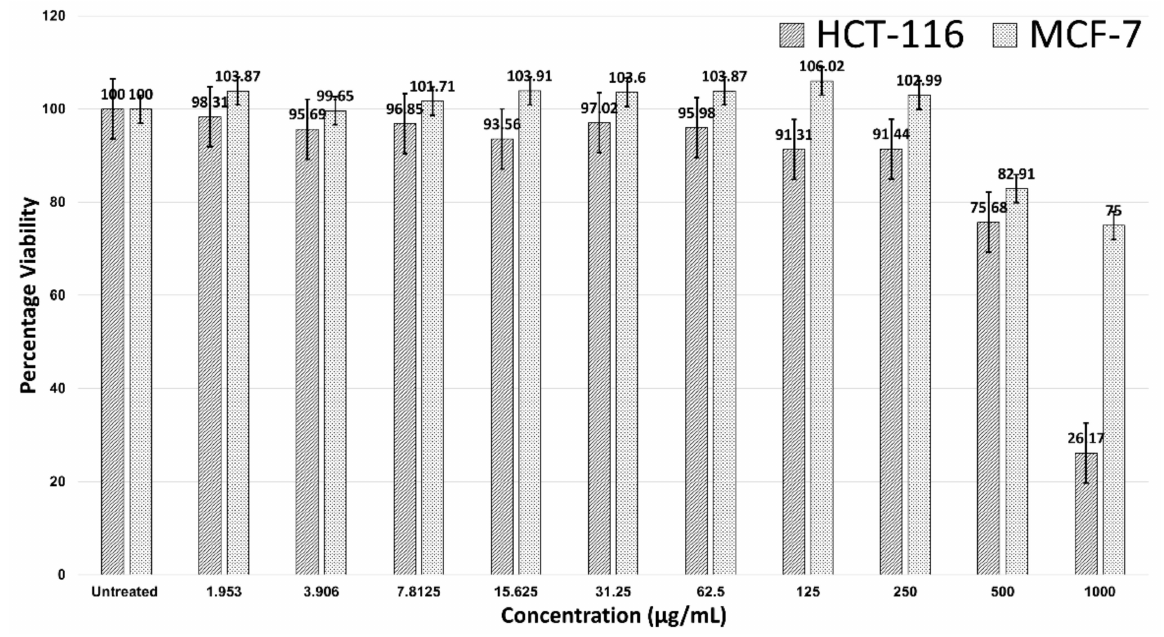
Figure 2. Cell viability of HCT-116 and MCF-7 cells in treatment with